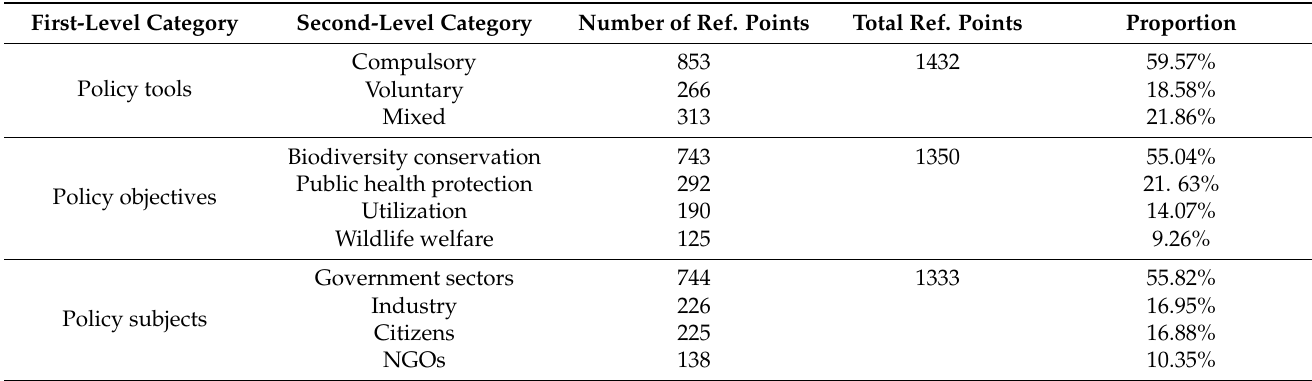
Table 3. Node Distribution of China’s Wildlife Management Policy Framework among Different Policy Tools, Objectives, and